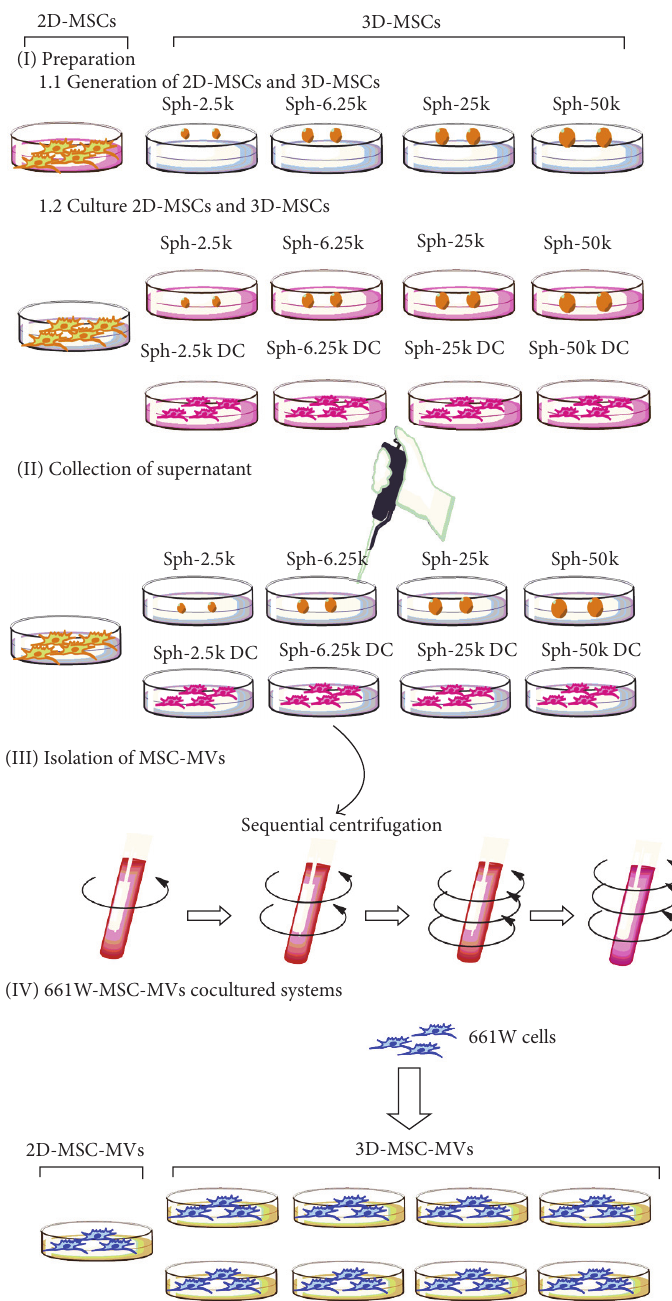
Figure 2: Schematic illustration of the experimental design. A part of MSCs were cultured in 2D environment (2D-MSCs) and hanging drop protocol was used to prepare spheroid MSCs (I). Different forms of conditioned medium were collected after 24 h (II). MSC-MVs were isolated from conditioned medium of MSCs based on sequential centrifugation (III). 2D-MSC-MVs/3D-MSC-MVs were cocultured with 661W cells for different time period